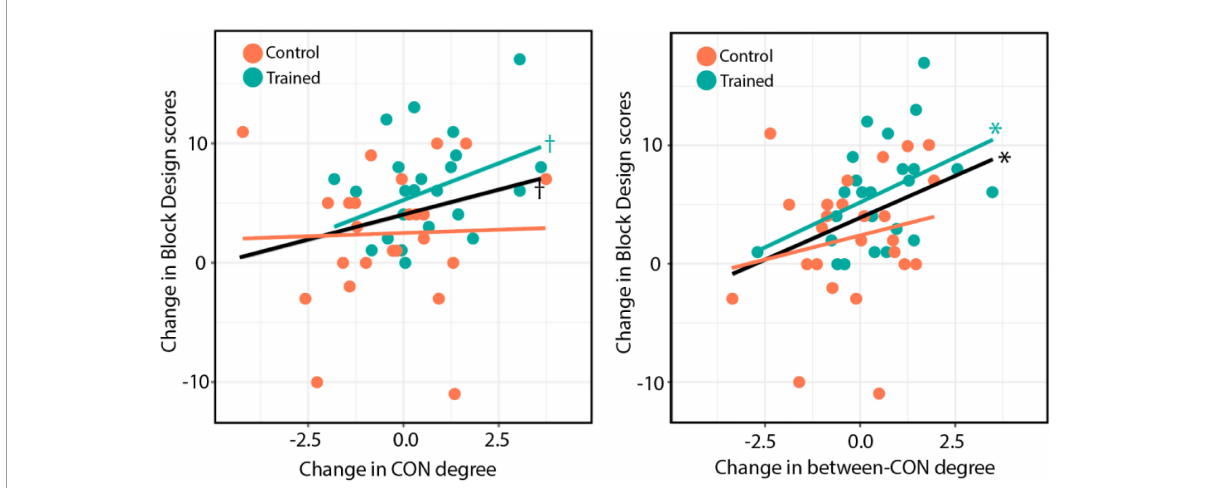
FIGURE6 (Left) Changes in total-CON degree for individual subjects across both groups plotted against changes in Block Design test performance after training. (Right) Changes in between-CON degree plotted against changes in Block Design test performance after training. The black line indicates the regression line for both groups, whereas the blue and orange lines indicate the regression lines for the training and control groups, respectively. The results of significance tests are indicated beside the corresponding regression lines (* p < 0.05; † p <